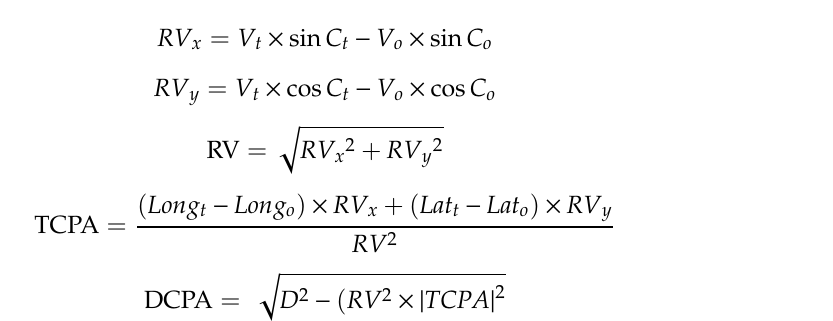
Figure 6. Illustration to help understand the DCPA, TCPA concepts, and their calculations.